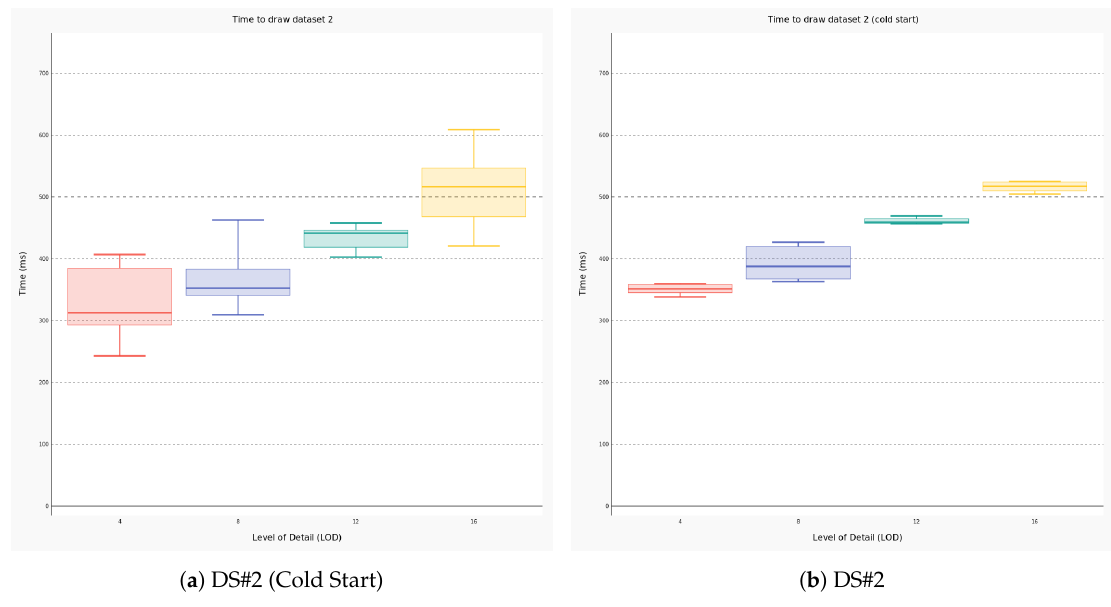
Figure 19. Time to represent